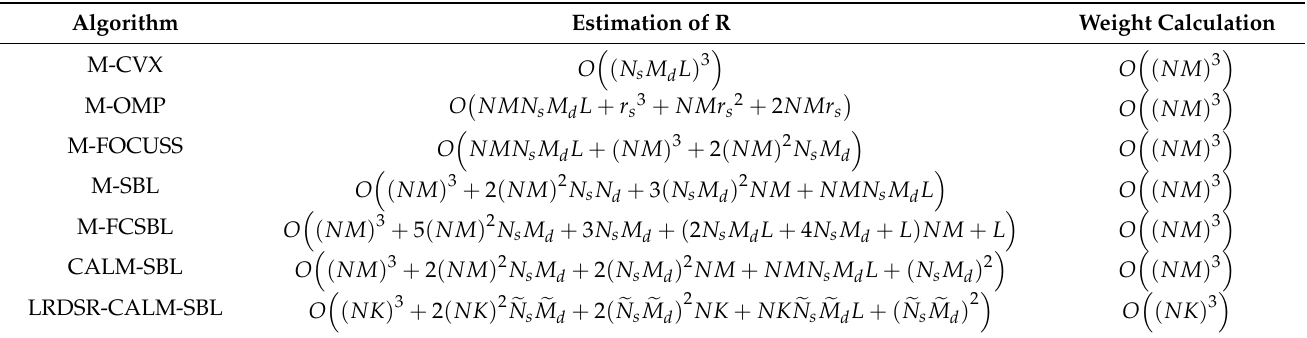
Table 1. Computational complexity comparison.